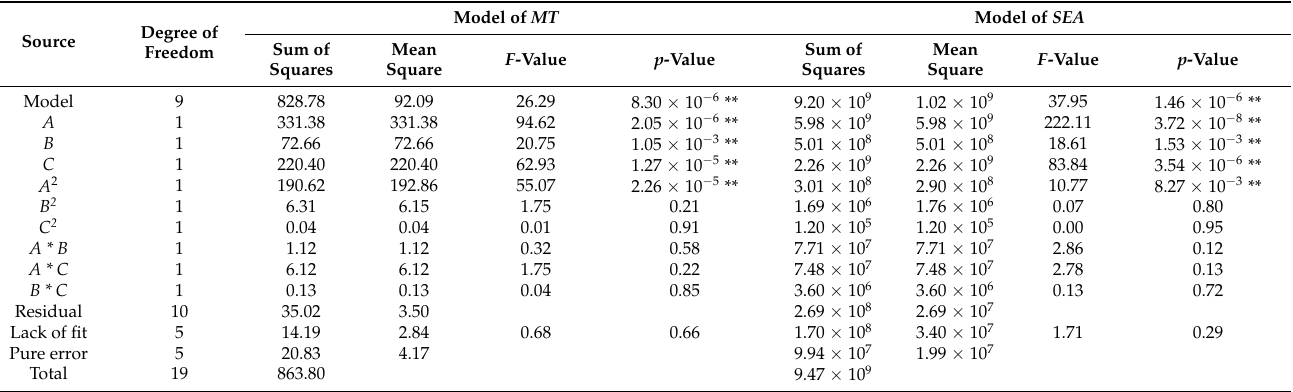
Table 9. ANOVA results for the complete quadratic model of MT and SEA .